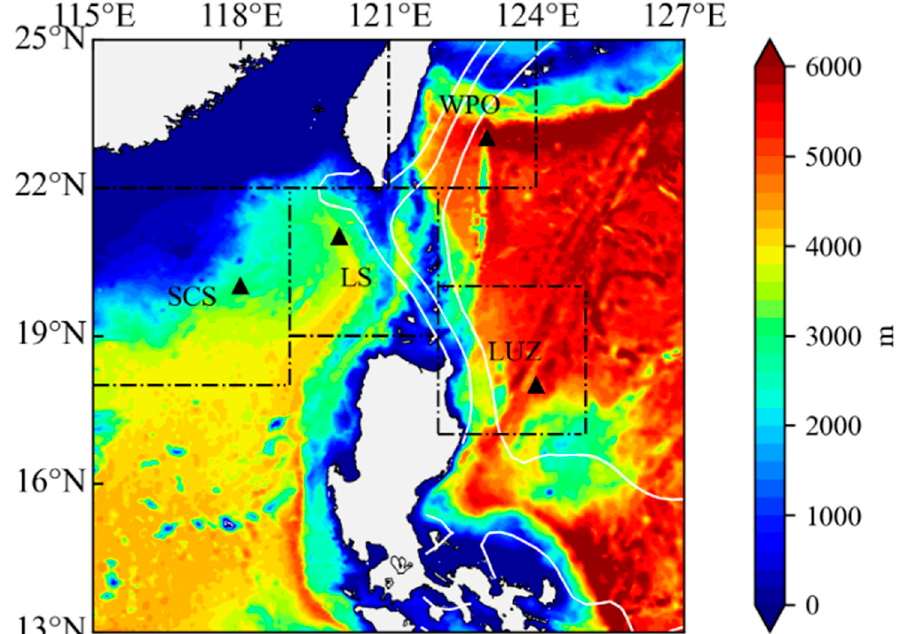
Figure 1. Schematic diagram of the research area and four sub-regions. They are: eastern Luzon island (LUZ), Luzon Strait (LS), eastern Taiwan-Northwest Pacific Ocean (WPO) and South China Sea (SCS). The positions of single points used for spectral analysis are represented by black triangles, which are 18° N, 124° E; 21° N, 120° E; 23° N, 123° E; 20° N, 118° E, respectively. The base map data are from ETOPO1 (unit: m) and mean dynamic topography. Here, only 110, 120 and 130 cm contour lines of MDT (white) are drawn to mark the Kuroshio axis.